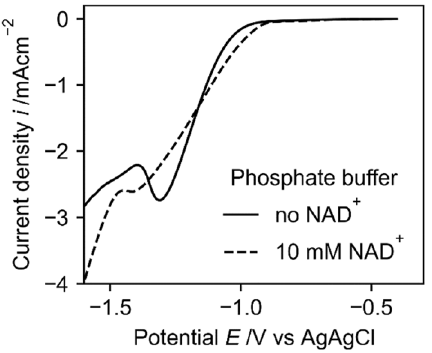
Figure 1. Linear potential sweep from − 0.4 to − 1.4 V with the scan rate of 0.1 V/s vs. Ag|AgCl|KCl3M in 0.1 M phosphate buffer pH 7 with and without NAD + at a copper